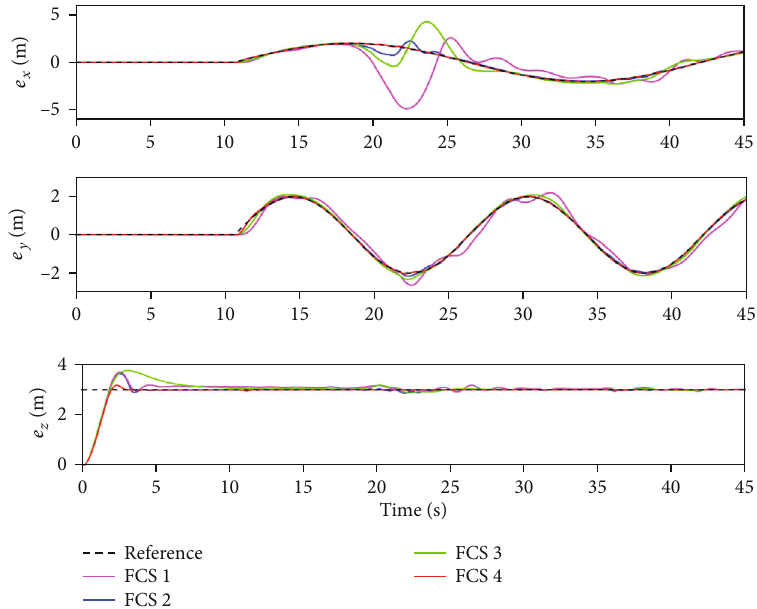
Figure 20: Pro fi les of the position of the quadrotor: translational variables ð x , y , z Þ : fl ight scenario